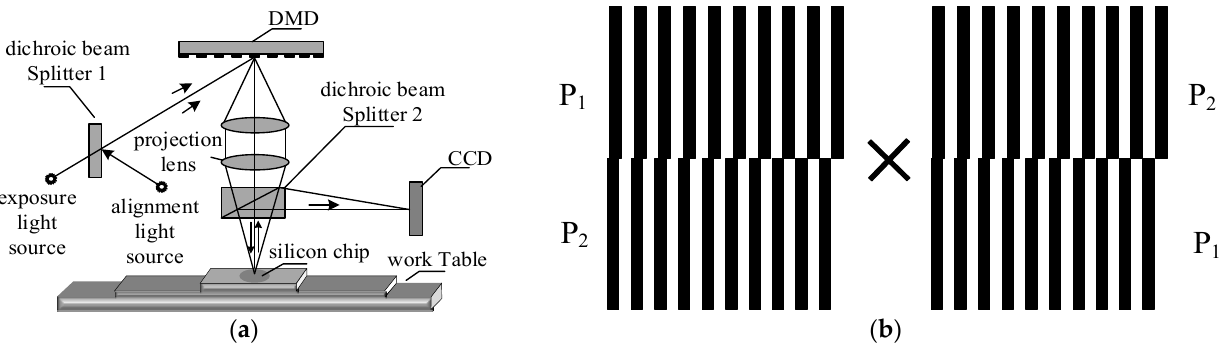
Figure 2. Generation method of lithographic aligned Moiré fringe based on digital grating. ( a ) Digital micro-mirror device (DMD) digital grating alignment system. ( b ) Digital grating alignment mark.